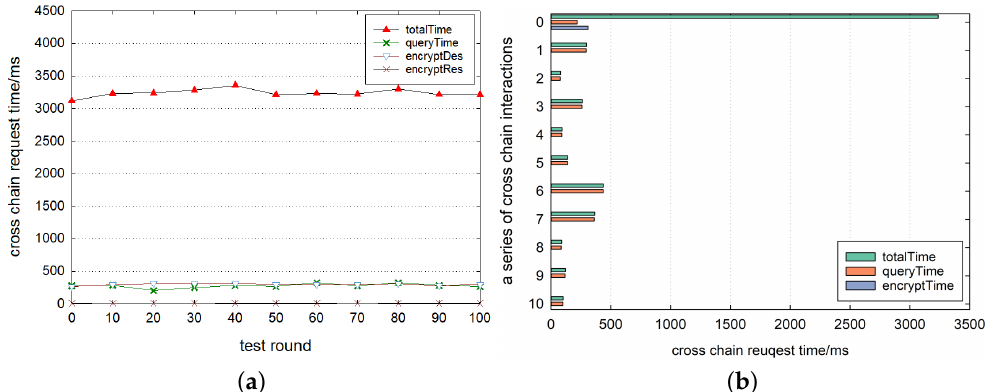
Figure 7. Cross-chain time latency. ( a ) First cross-chain request tests and ( b ) a series of cross-chain request